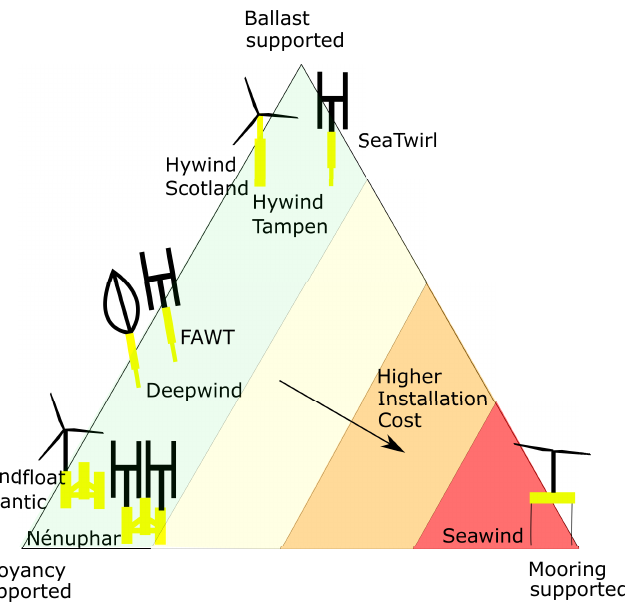
Figure 7. Stability triangle with buoyancy, mooring and ballast supported structures at the vertices of the triangle. Examples of floating VAWTs and HAWTs are identified in the figure. The colour bar in the triangle indicates installation costs, with costs increasing from light green to